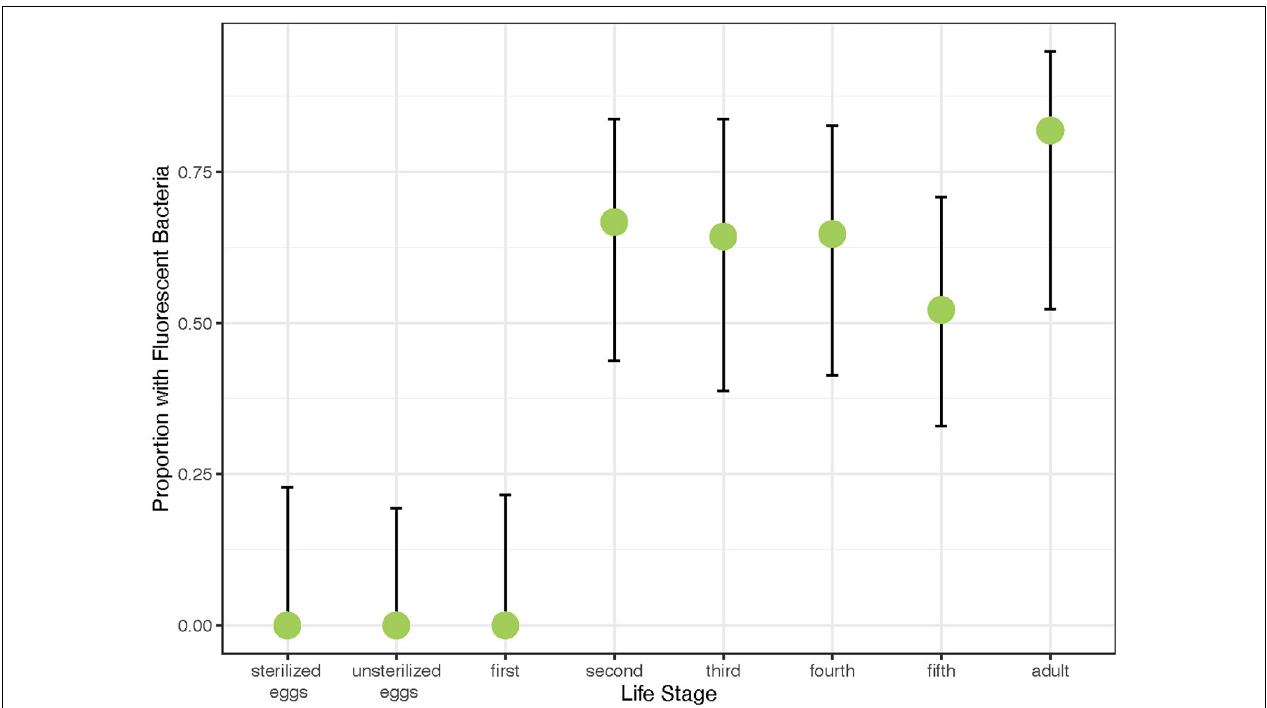
FIGURE 4 | Proportion of offspring of different life stages harboring GFP-labeled Caballeronia sp. SQ4a when reared on plants with parents previously inoculated with GFP-labeled Caballeronia sp. SQ4a. Error bars are binomial confidence intervals. Sample sizes are 13 sets of two sterilized eggs, 16 sets of two unsterilized eggs, 14 first instar nymphs, 18 second instar nymphs, 14 third instar nymphs, 17 fourth instar nymphs, 23 fifth instar nymphs, and 11 adult